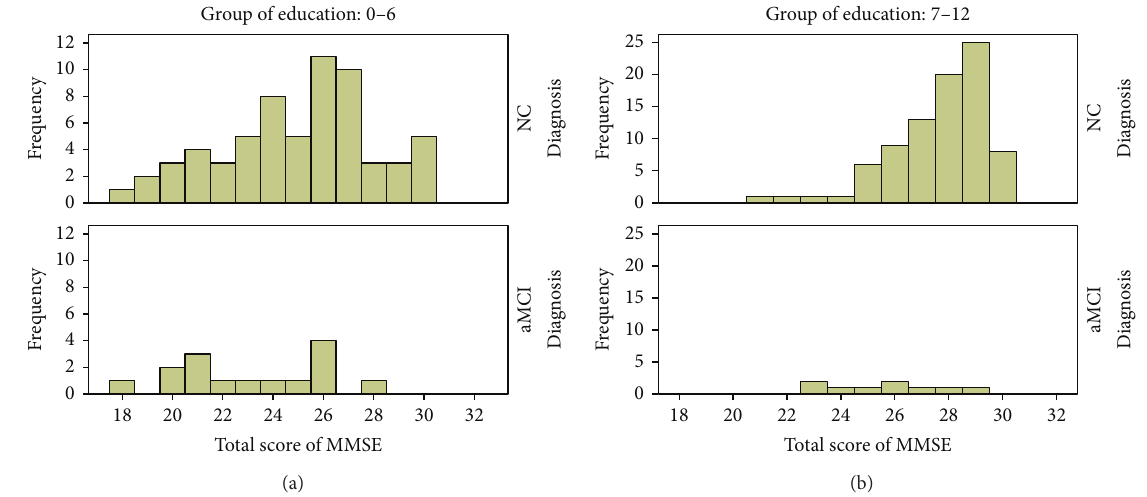
Figure 3: Frequency distribution of C-MoCA scores by aMCI status and education groups. (a) The 0–6 years of education group; (b) the 7–12 years of education group. NC: the participants for normal control; aMCI: the participants for amnesic mild cognitive